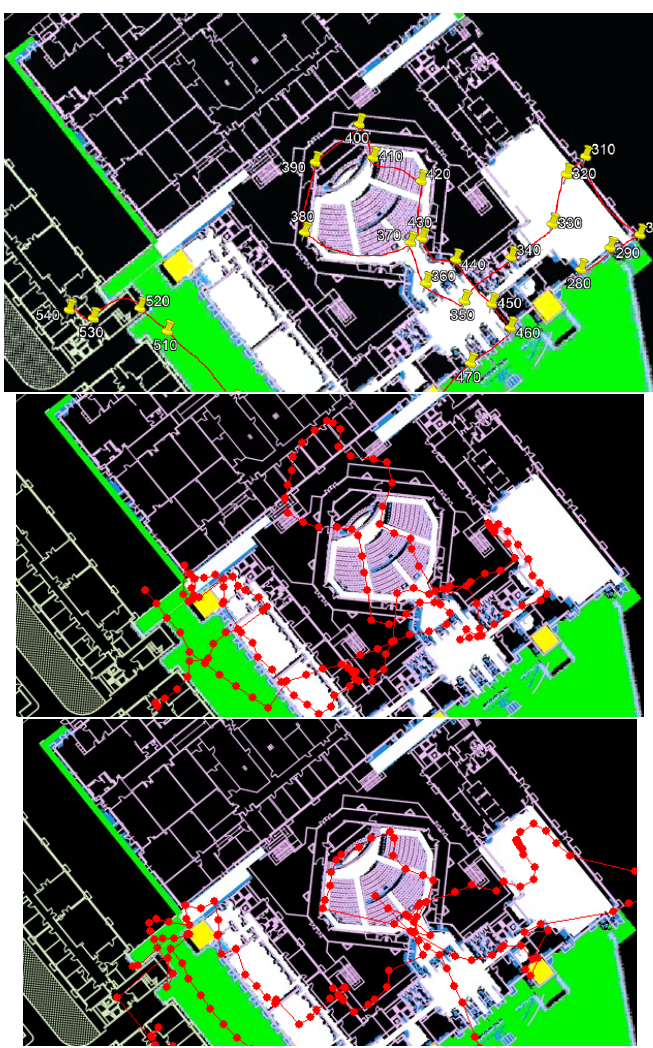
Figure 22. The benefit of using a global (sparse) position system as a geolocation service for the resample process. ( Top ): ground truth. ( Center ): STEPS report without geolocation service resample. ( Bottom